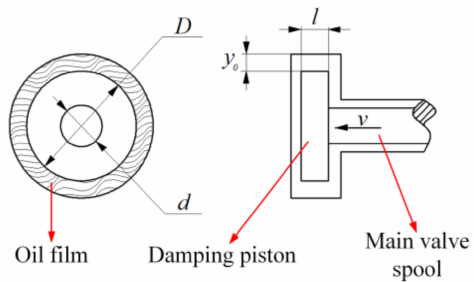
Figure 7. Schematic diagram of damping piston